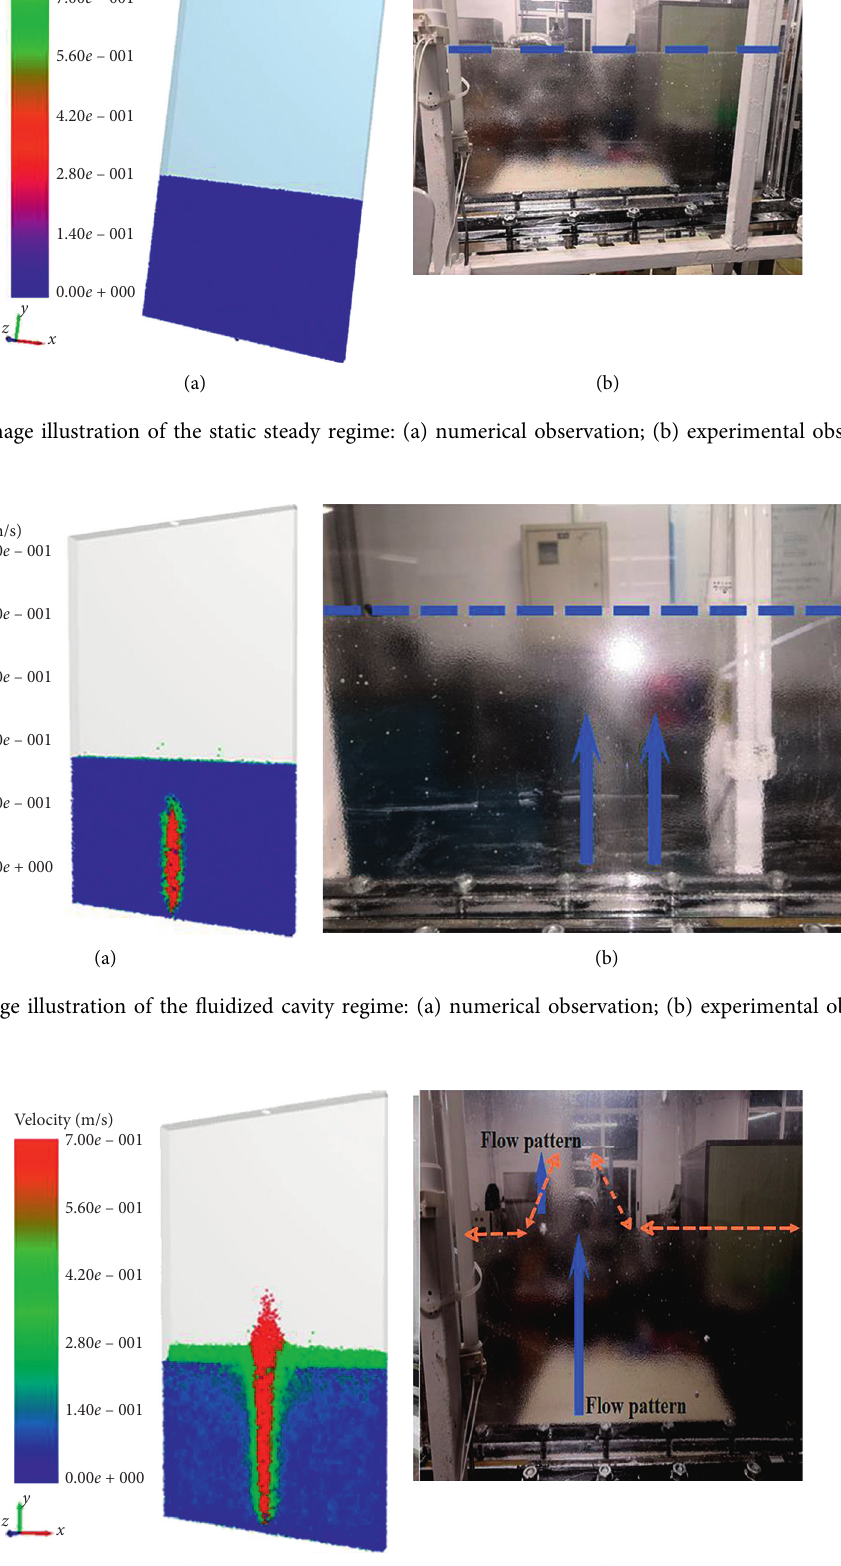
Figure 6: Image illustration of the fluidized chimney regime: (a) numerical observation; (b) experimental